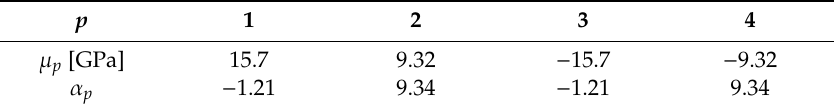
Table 3. Ogden material model parameters for subcutaneous soft tissue used in the study.